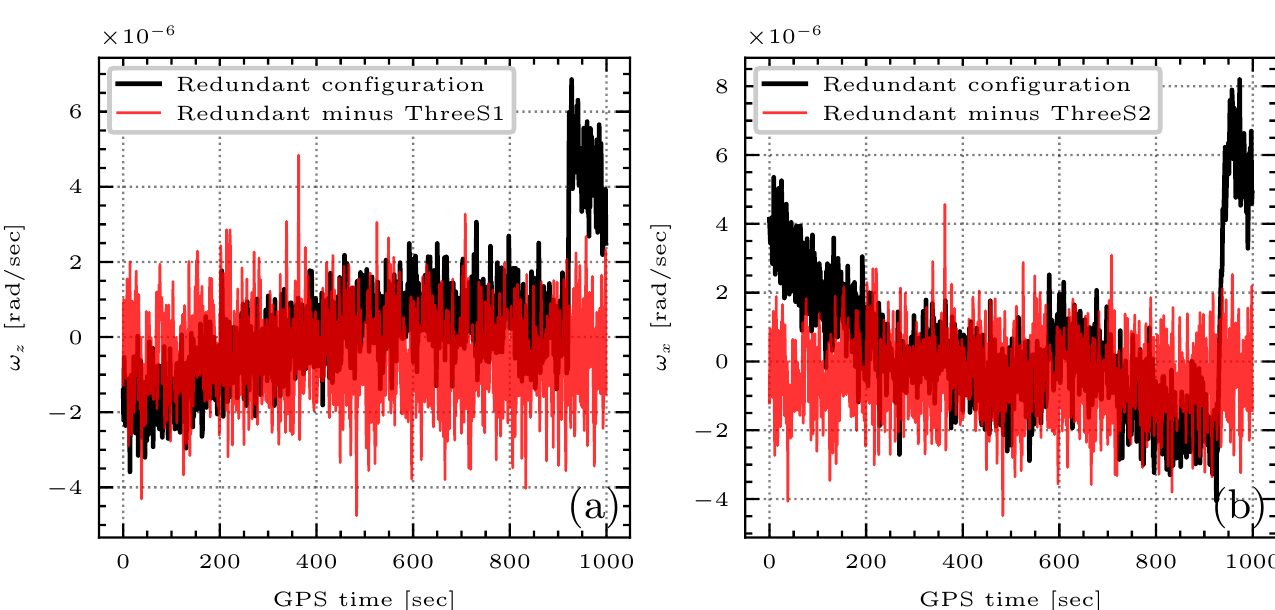
Figure 3. Comparisons of derived angular velocities between four-sensors redundant configuration and three-sensors strategies. ( a ) denotes the ω z , and ( b ) denotes the ω x